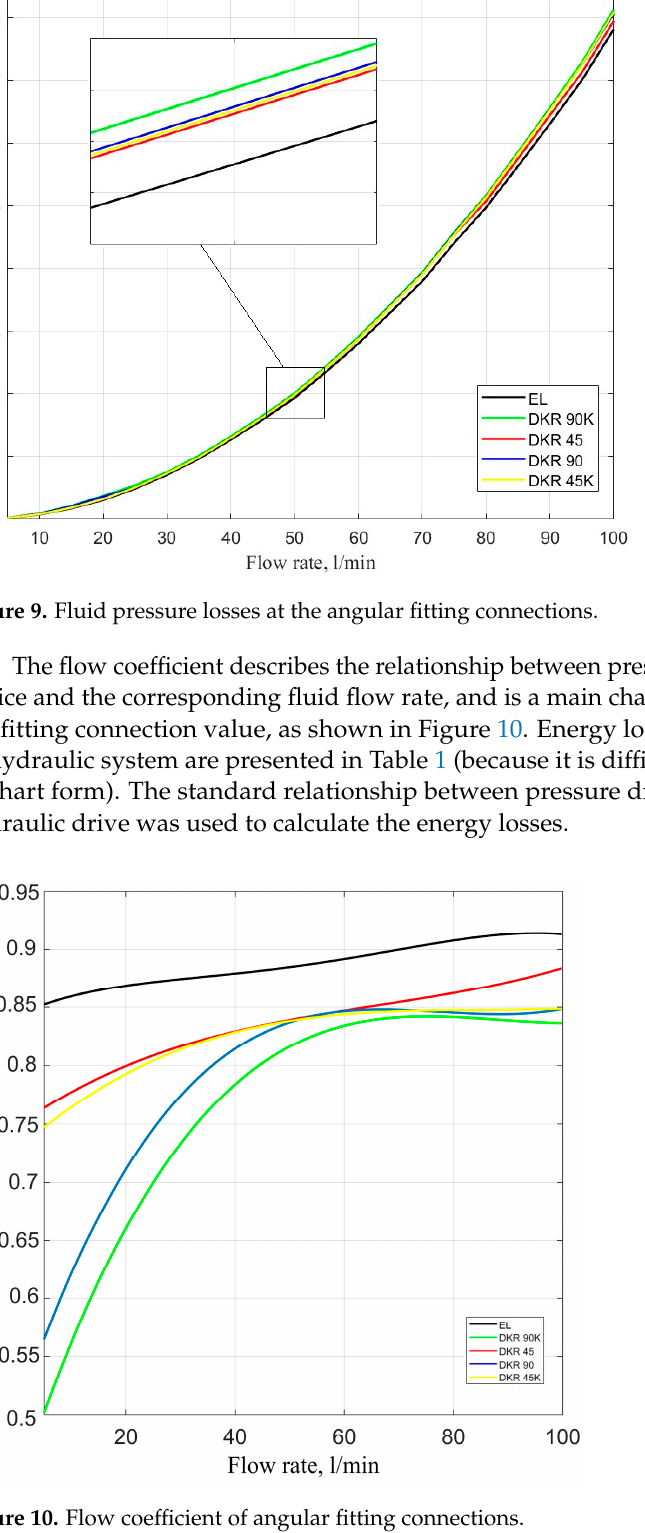
Figure 10. Flow coefficient of angular fitting connections.